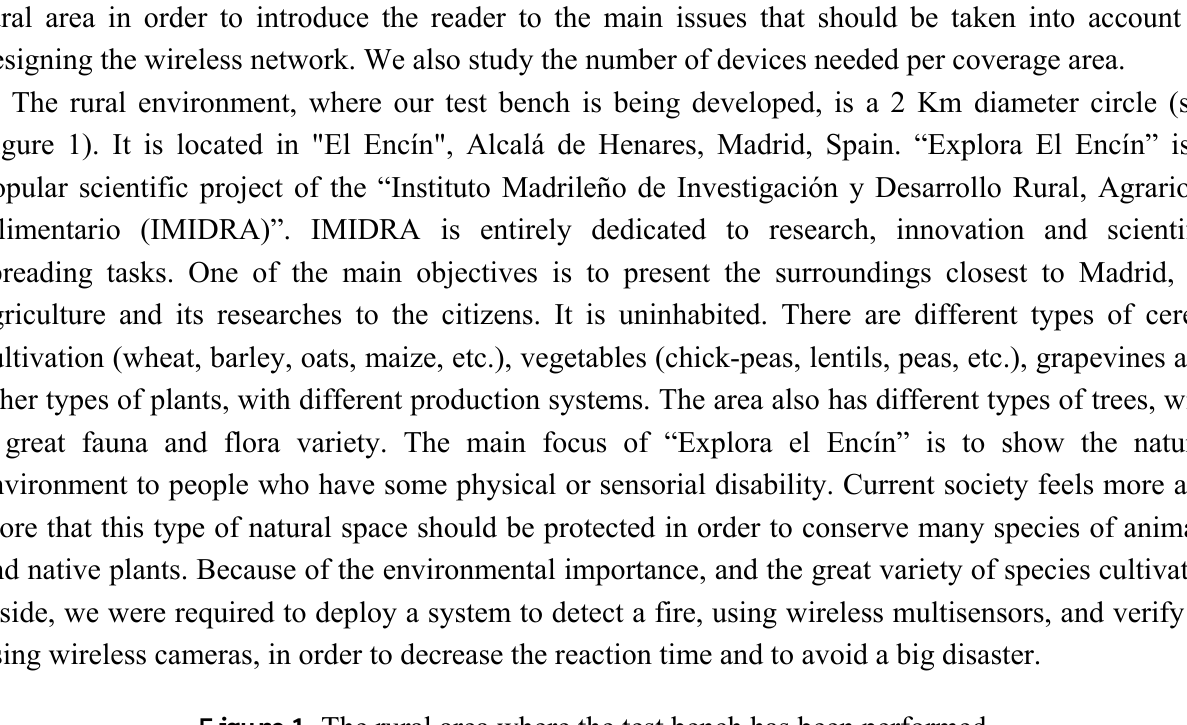
Figure 1. The rural area where the test bench has been